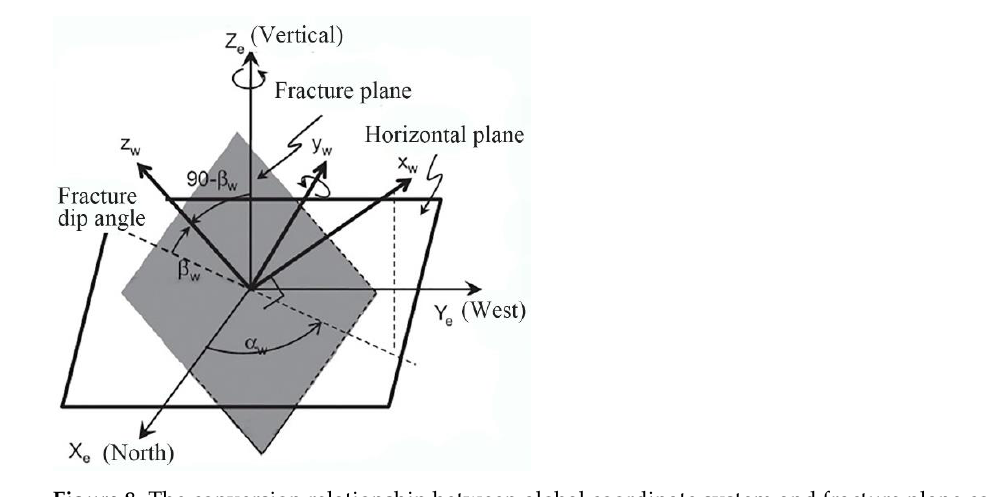
Figure 8. The conversion relationship between global coordinate system and fracture plane coordi- nate system.